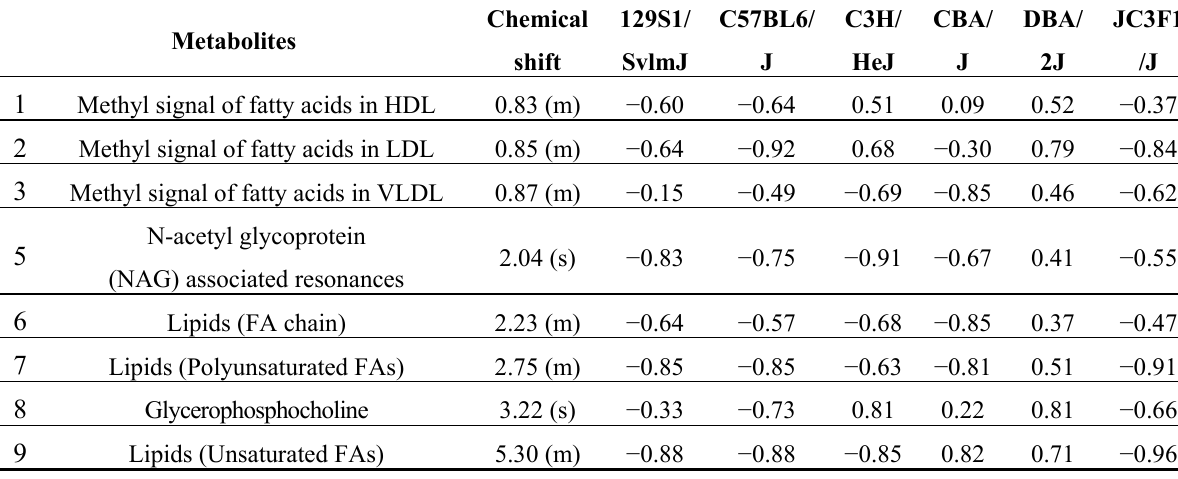
Key : Importance of metabolic changes is indicated by their correlation coefficients in the respective pairwise OPLS-DA multivariate analyses between controls and CR group for each mouse strain. The report values correspond to the p (corr) variables. Threshold for significant metabolites was calculated based on two-tailed probability of a Pearson correlation coefficient ( r = 0.68, p < 0.001, n = 20), (s = singlets, m =